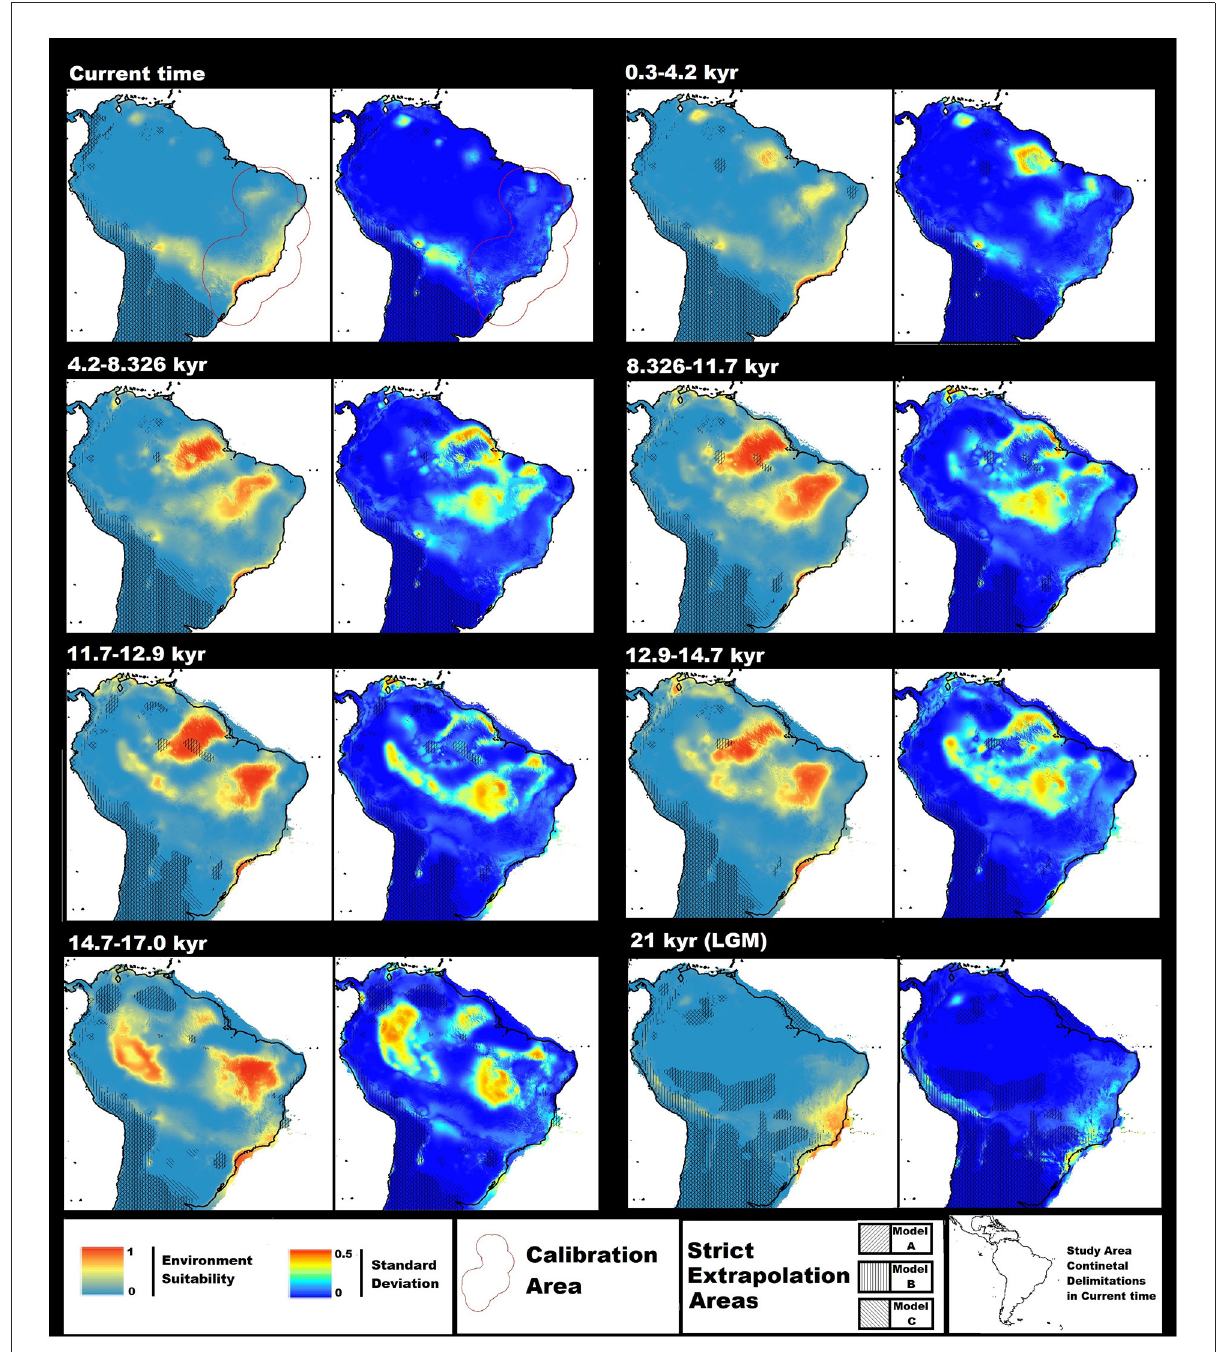
FIGURE2 Average Ecological Niche Model (ENM) and standard deviation models for Rhodnius domesticus transfers in different spatial and temporal scenarios: Current time; 0.3–4.2; 4.2–8.326; 8.326–11.7; 11.7–12.9; 12.9–14.7; 14.7–17.0; and 21 kyr [last glacial maximum (LGM)]; names above the corresponding ENM in the left and standard deviation in right. Environmental suitability ranges from 0 to 1, standard deviation ranges from 0 to 0.5, both represented by values increasing from colder to warmer colors. Values were normalized as maximum 1 and 0.5, respectively, to allow models’ comparisons. The red polygon indicates the calibration area in the current time map. The black line indicates continental delimitation for the current time. Strict extrapolation areas for Models (A–C) are indicated by different patterns and overlapped on top of corresponding average transfer ENMs. Regions outside this line emerge continental shelf for the period. The maps have been projected using WGS 1984 datum and coordinate system and delimitated by a rectangle in latitudes 14 and − 36 and longitudes − 82 and −